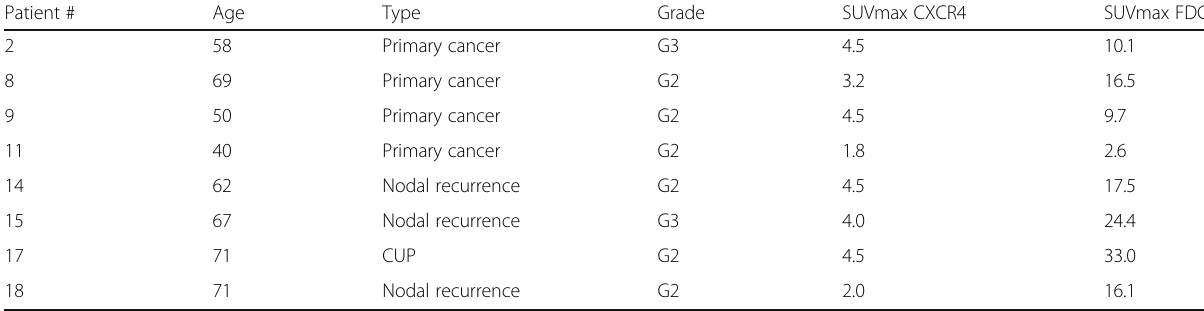
Table 5 Additional FDG PET/CT was performed in 8 patients within 1 week after CXCR4-targeted PET Patient #